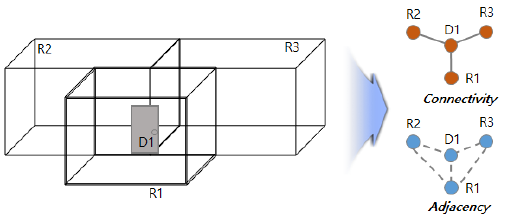
Figure 5. IndoorGML Topological Relationships